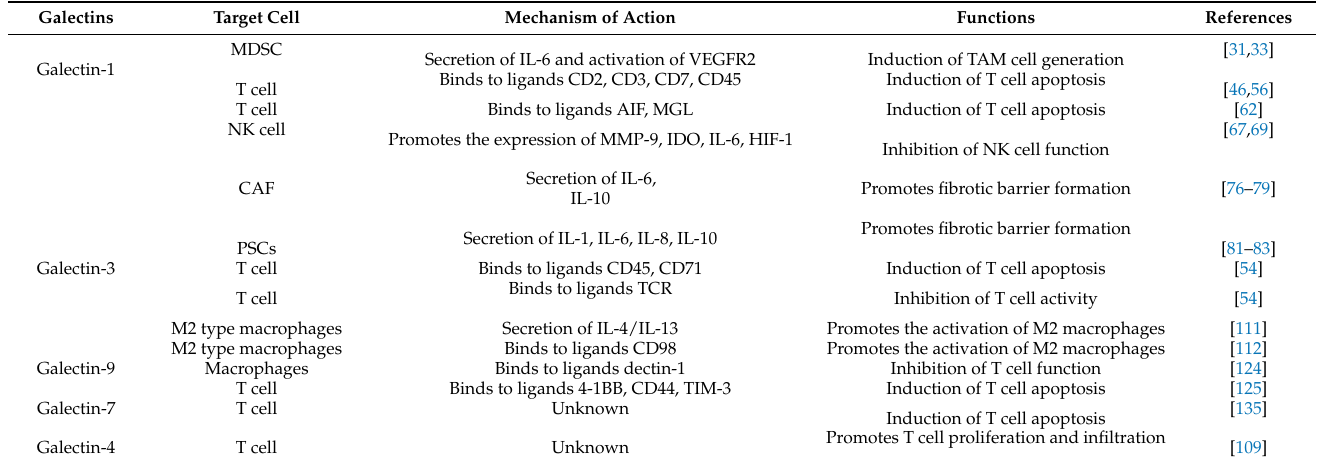
Table 1. Role of different galectins in immune evasion of PDAC